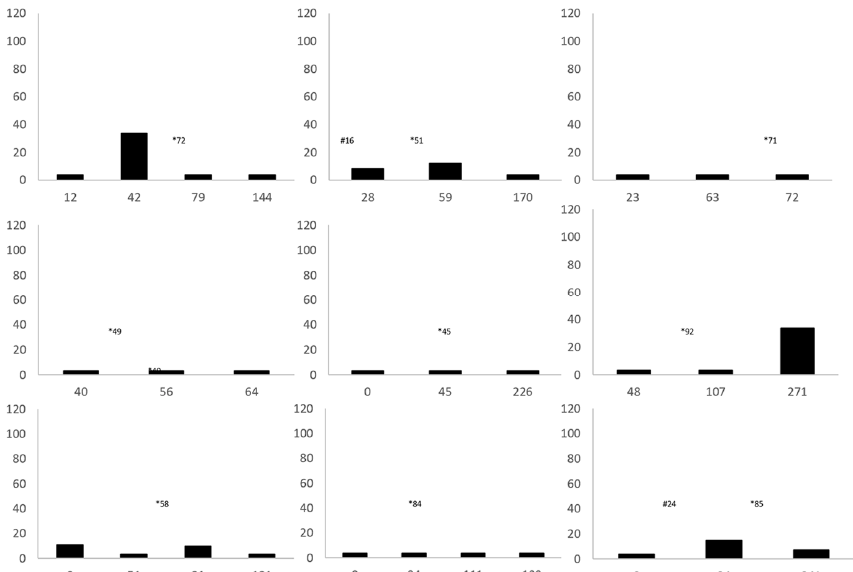
Figure 4. Vitamin E plasma concentrations over time in individual cold-stunned Kemp’s ridley sea turtles ( Lepidochelys kempii ) with steatitis. The X -axis is days of rehabilitation, and the Y -axis is plasma vitamin E concentrations in nmol/g. * represents the day of diagnosis of steatitis. # represents the day of injectable vitamin E administration for patients that received this treatment ( n = 2).